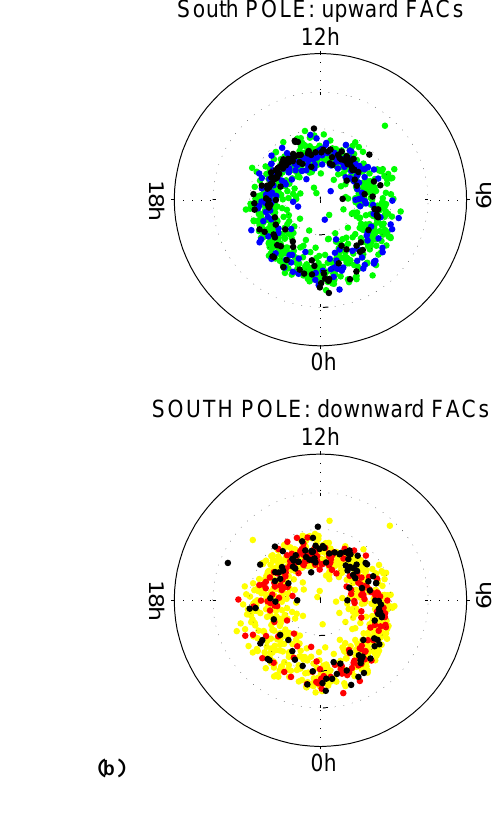
Fig. 6. Upward and downward field-aligned currents (FACs) at the north and south poles for quiet periods during the entire time period of this study. Shown are the latitudinal distributions (cgm) of the peak values versus magnetic local time (MLT). The current peaks were determined after applying a 20-s running mean to the 1-s time series. The amplitudes are color coded, with black points representing the strongest peaks in all four panels. The latitude circles are spaced by 10 ◦